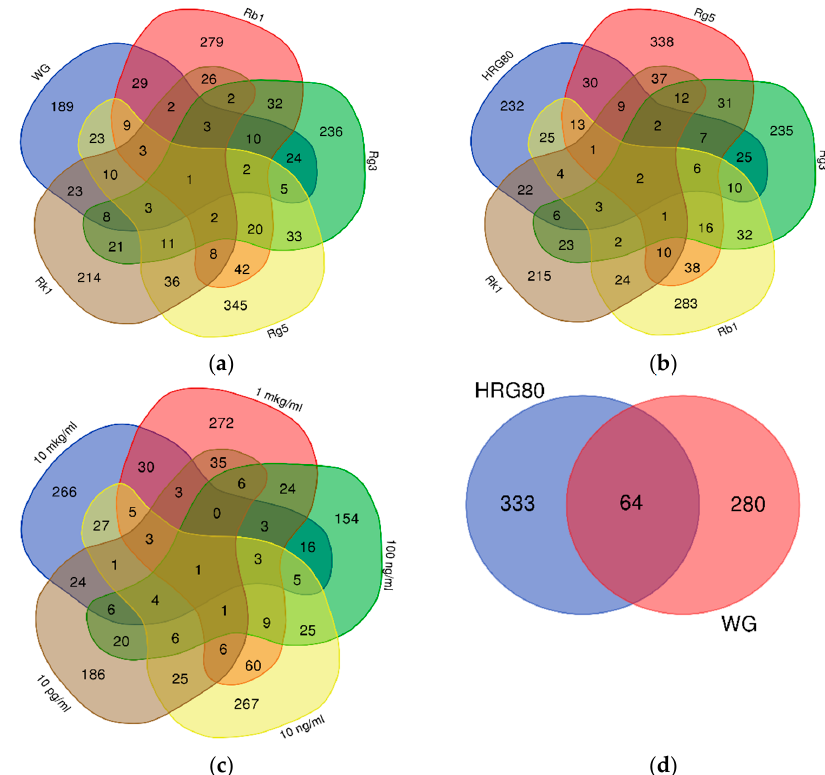
Figure 1. Venn diagrams of: ( a ) the number of genes deregulated by WG and ginsenosides Rb1, Rg3, Rg5 and Rk1, ( b ) the number of genes deregulated by HRG and ginsenosides Rb1, Rg3, Rg5 and Rk1, ( c ) the number of genes deregulated by HRG at concentrations of 10 μ g/mL, 1 μ g/mL, 100 ng/mL, 10 ng/mL, and 0.01 ng/mL; ( d ) the number of genes deregulated by WG and HRG in the hippocampal neuronal cell line